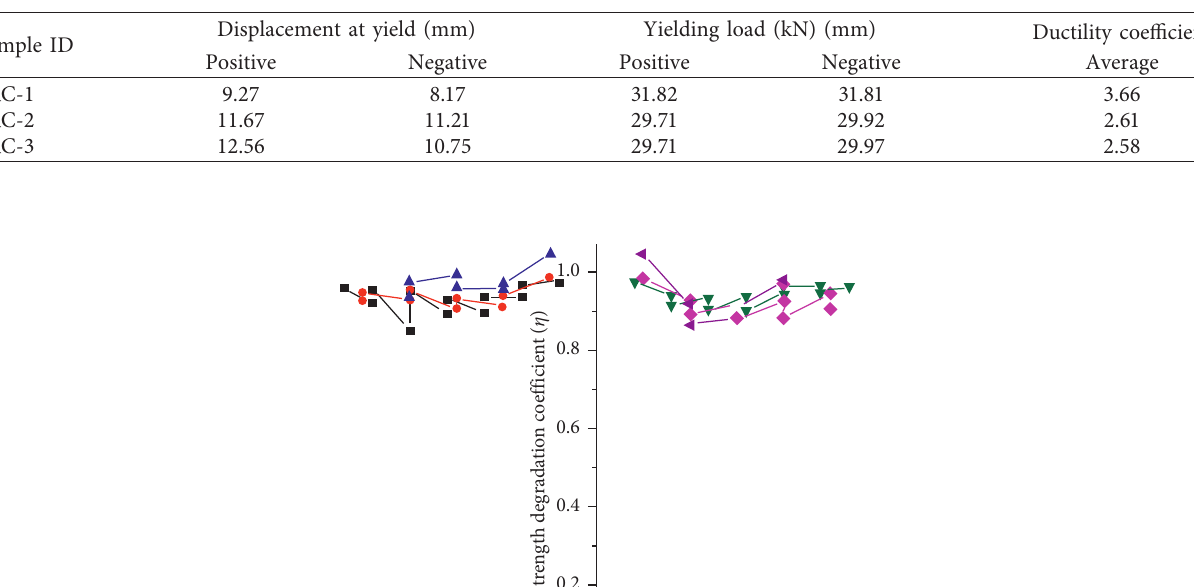
Table 5: Displacement and ductility detail.